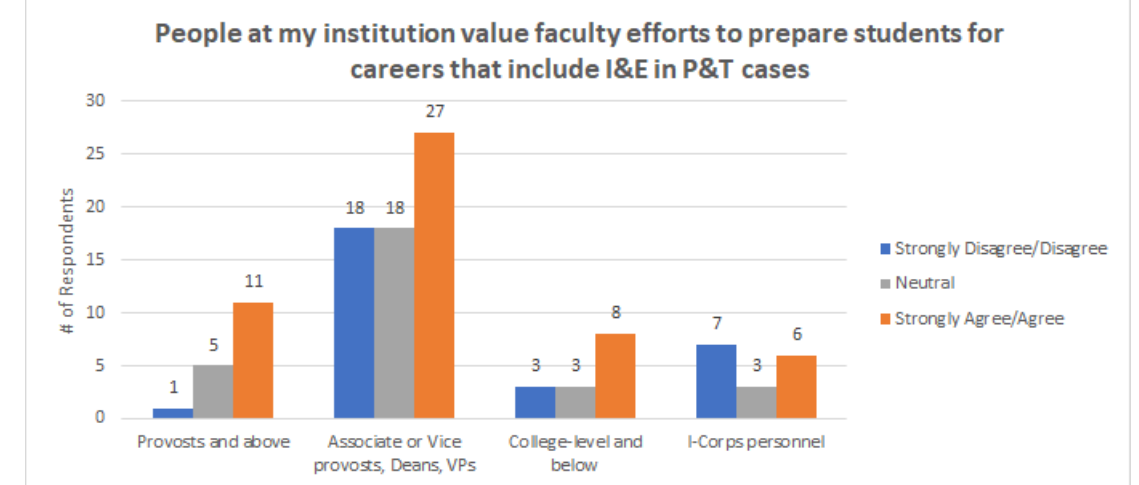
Figure 5. Comparison of respondents’ perceptions of how other people at their institution value in P&T cases faculty efforts to prepare students for careers that include I&E.